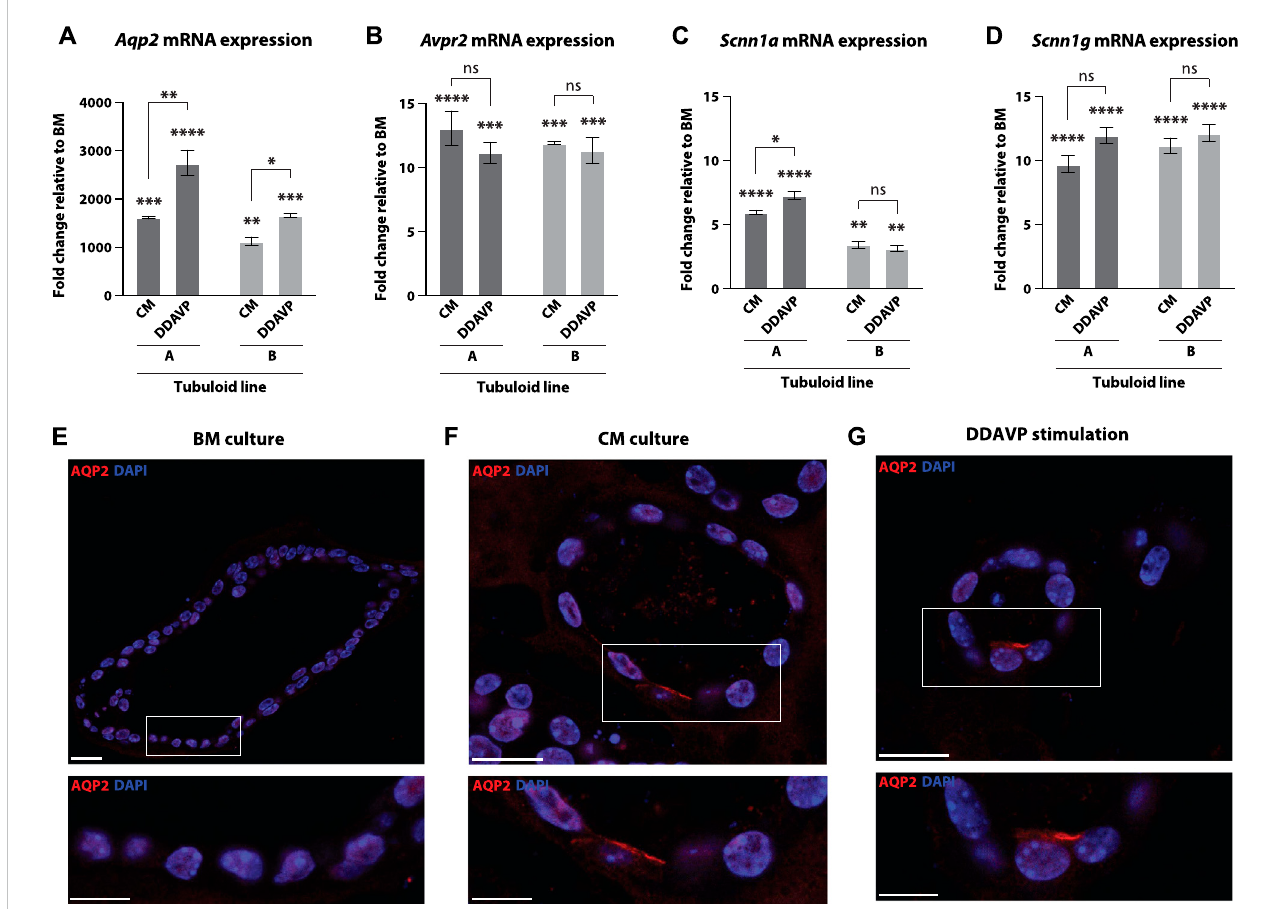
FIGURE 4 Mouse tubuloids stimulated with DDAVP show increased mRNA expression of various CD transporters and apical expression of the AQP2 protein. Fold change mRNA expression of tubuloid line (A, B) cultured in CD medium (CM) and DDAVP stimulation medium compared to basal medium (BM). mRNA expression of CD water transporter Aqp2 (A) , theV2R ( Avpr2 ) (B) , the alpha (C) and gamma (D) subunits of ENaC ( Scnn1a and Scnn1g )in 2 tubuloid lines (A, B), after culture in CM or DDAVP stimulation medium ( N = 2 duplicates). Representative immuno fl uorescence pictures of stainings of the apical water channel AQP2 (red) on tubuloids cultured in BM (E) , CM (medium including forskolin) (F) and DDAVP stimulation medium (G) . Inserts (white rectangle) are displayed directly below the main image (E – G) . Tubuloids were stained for nuclei (DAPI, blue) (E – G) . Scale bars 20 μ m and inserts 10 μ m. ns, not signi fi